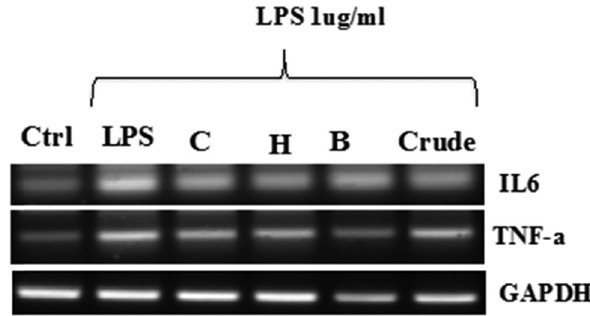
Figure 3: E ff ect of extract on LPS - induced gene expression of in fl ammatory cytokines. THP - 1 di ff erentiated macrophages were incubated with di ff erent fractions of extracts for 1 h and stimulated with 1 µg/mL LPS for 24 h. Expressions of TNF - α and IL6 were eval - uated using semi - quantitative PCR. In this, a negative control was taken in the absence of LPS and extract whereas positive control was taken as only LPS treated. GAPDH was used as a loading control.